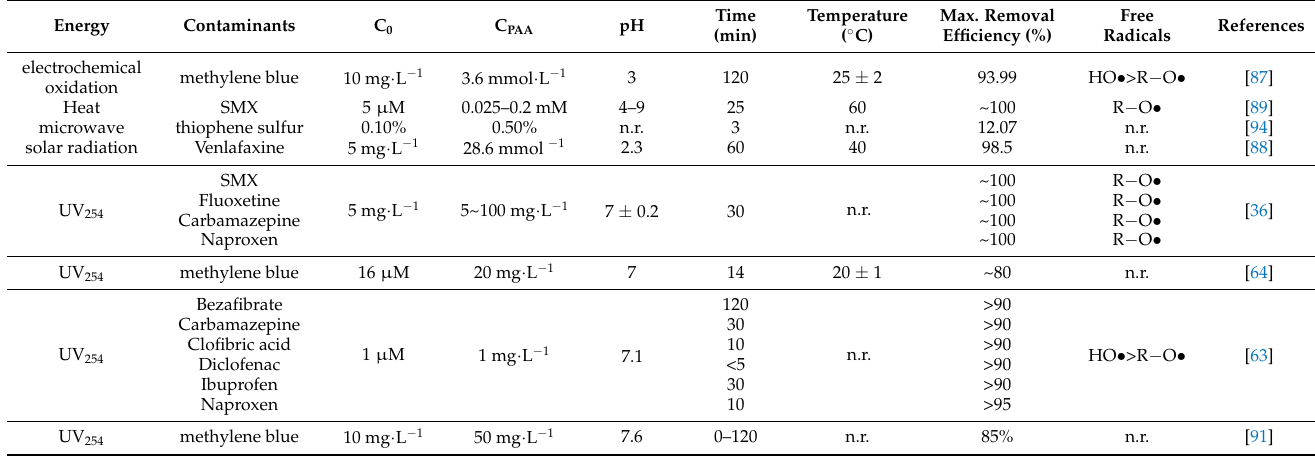
Table 4. Studies of activating PAA by